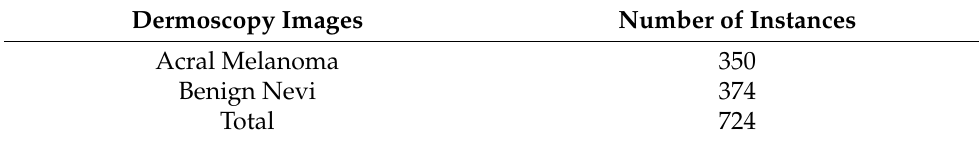
Table 2. Class-wise distribution of dataset.